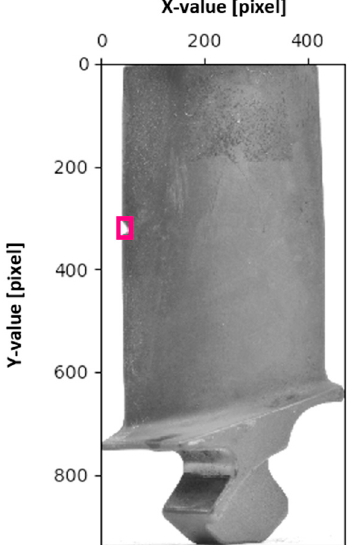
Figure 11. Image coordinate system with origin at top left corner.